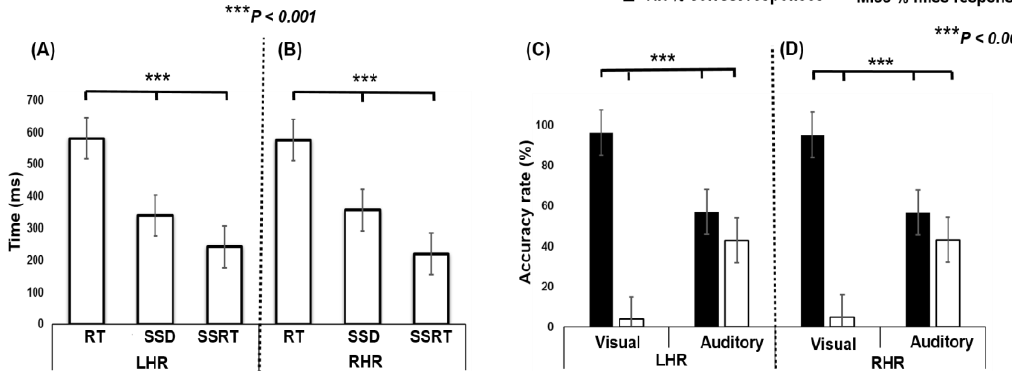
Figure 2. ( A ) Behavioral outcomes between visual stimuli and auditory alarms during LHR inhibition. ( B ) Behavioral results of visual stimuli and auditory alarms in RHR inhibition. Asterisks indicate pairwise significance difference (*** p < 0.001) in ANOVA: Single factor between the RT, SSD, and SSRT conditions. ( C , D ) Comparisons between hit% (i.e., accuracy rate) and miss% (i.e., inaccuracy rate) while responding to the visual-auditory stimuli during LHR and RHR inhibitions. Asterisks show significance di ff erence in ANOVA between the hit% and miss% with visual stimuli and auditory alarms.